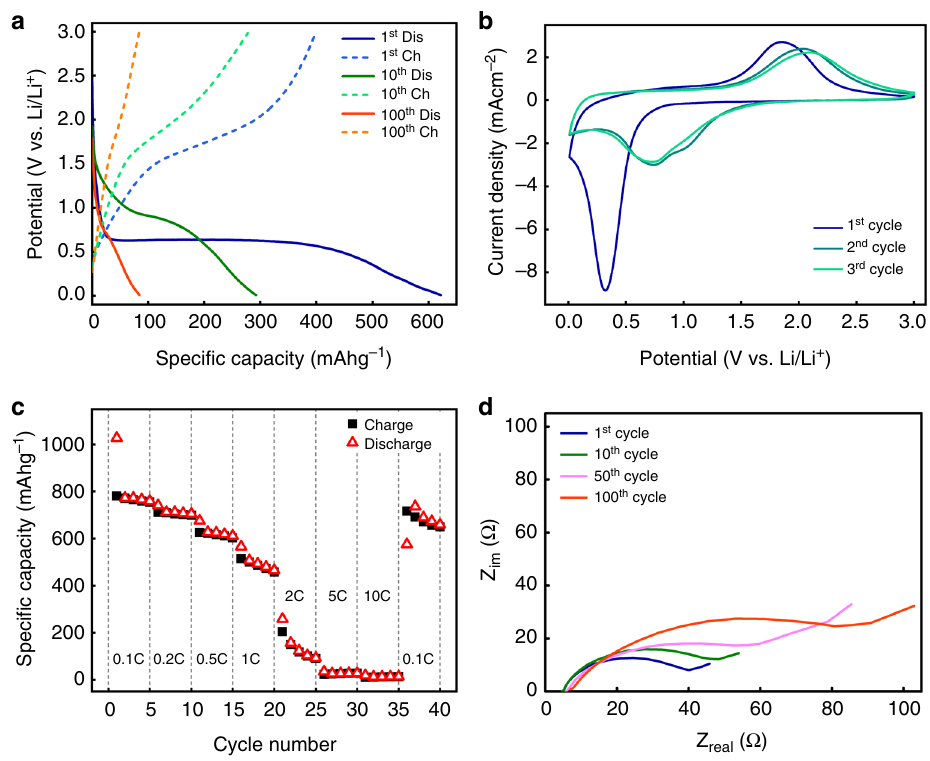
Fig. 1 Electrochemical properties. a Discharge and charge pro fi le of Fe 3 O 4 at 1st, 10th, and 100th cycle measured at rate of C/2 (463.5 mAg − 1 ), respectively. b Cyclic voltammograms of Fe 3 O 4 during fi rst three cycles at a scan rate of 1 mV s − 1 . c Rate capability plot of Fe 3 O 4 electrode d Impedance measurements of Fe 3 O 4 after 1st, 10th, and 100th cycle at rate of C/2, indicating the increase of internal resistance as a function of cycles